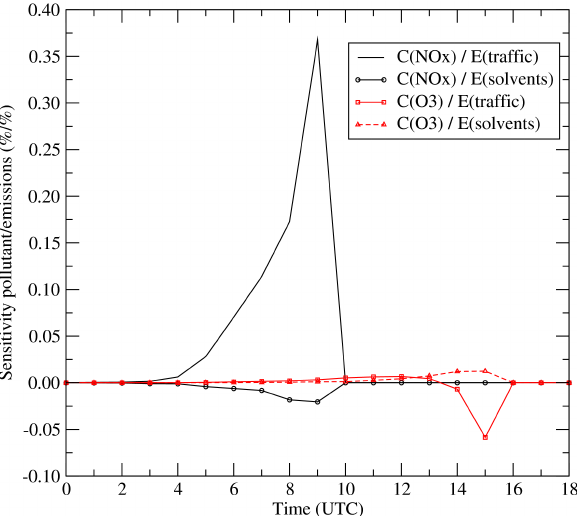
Fig. 14. Time series of the sensitivity of pollutants (NO x and O 3 ) to anthropogenic surface emissions (from “traffic” and “solvents” activity sectors).